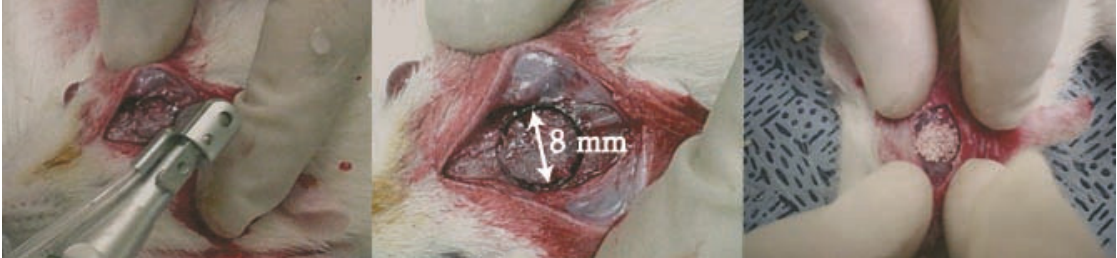
Figure 4. The surgical process (8 mm defect criteria).